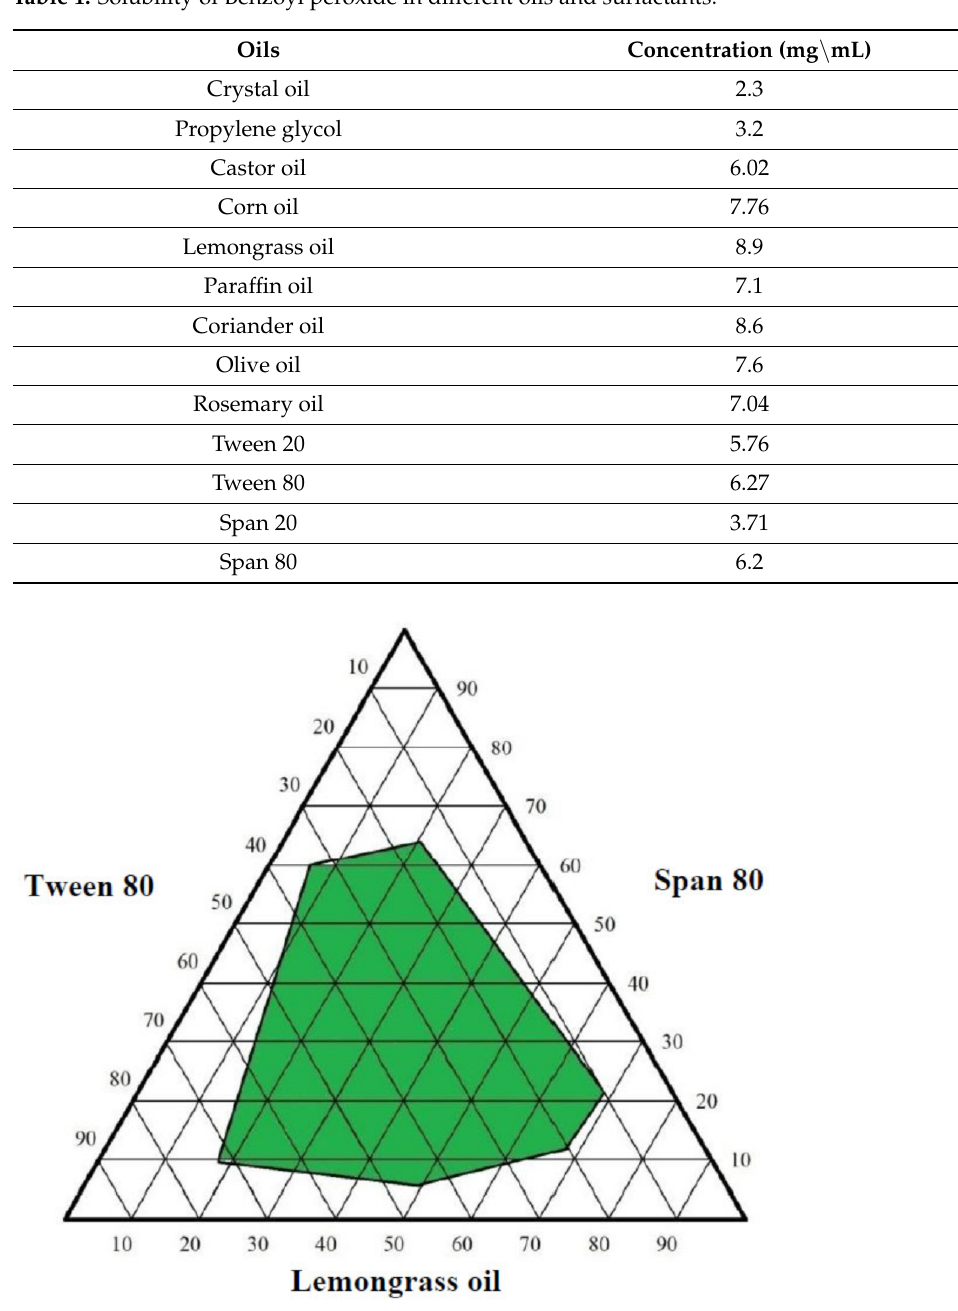
Table 1. Solubility of Benzoyl peroxide in different oils and surfactants.